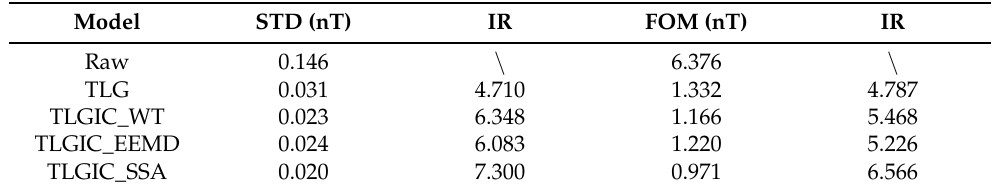
Table 2. Compensation results of the second–lap flight data by utilizing the compensation coefficients calculated by the first–lap